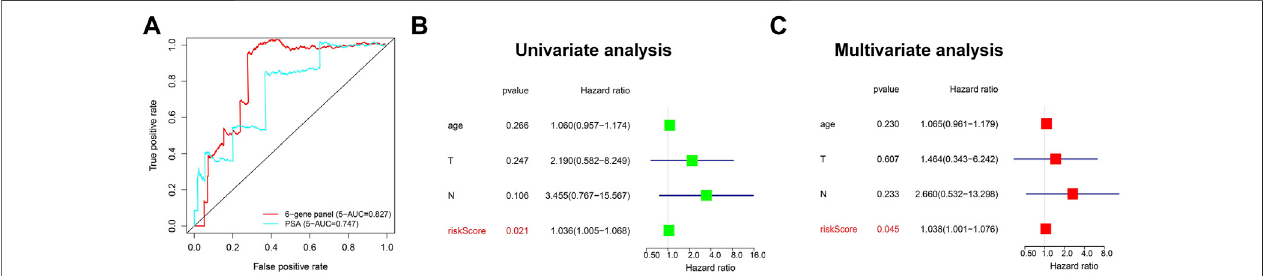
FIGURE 8 | Evaluation of the prediction performance of the 6-gene panel diagnostic scoring model in TCGA cohorts. (A) The predictive ef fi ciency of the 6-gene panel model and PSA were shown by a 5-year ROC curve. (B,C) Univariate and multivariate analysis of the correlation between clinicopathological features and overall survival of PCa